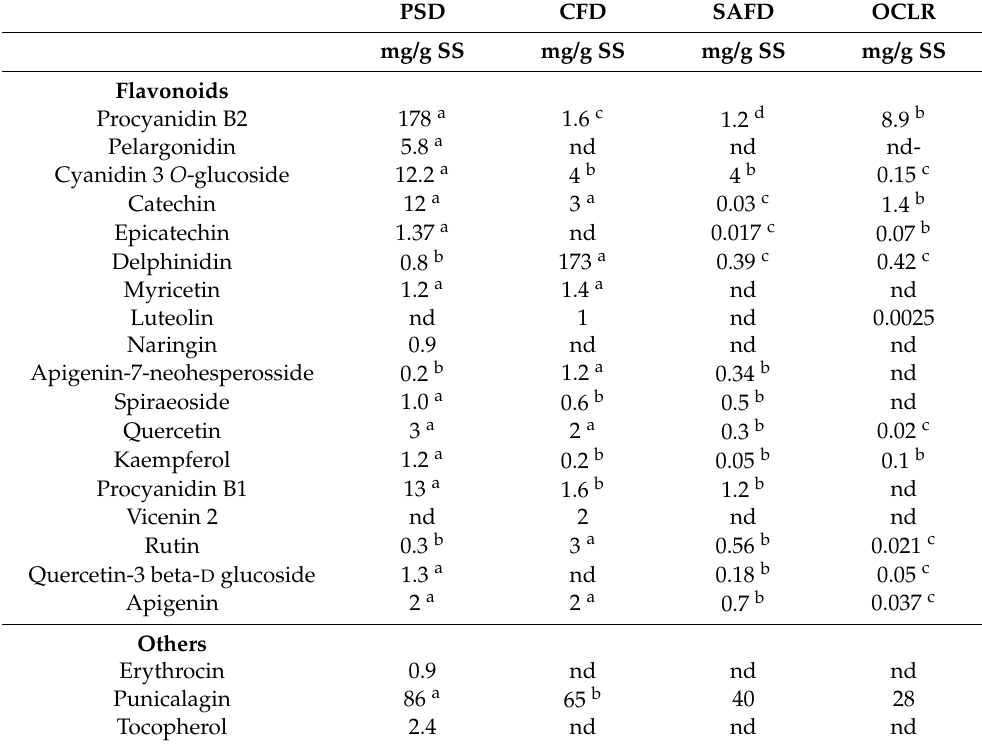
Different letters in the same row indicate significant differences p ≤ 0.05. Table 2. Single flavonoids in peels of different pomegranate cultivars dried differently. PSD (spray- dried Wonderful peel, experimental data); CFD (Calabrian Wonderful peel freeze-dried, experimental data); SAFD (South African Wonderful peel freeze-dried, literature data); IC (Indian cultivar peel freeze-dried, literature data). The experimental data are the mean of six